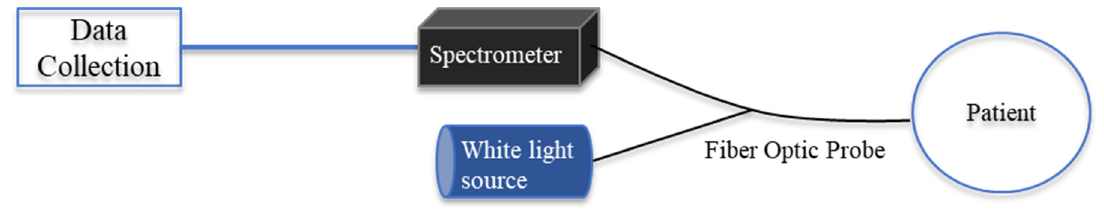
Figure 1. Diagram of spectral probe experimental setup.